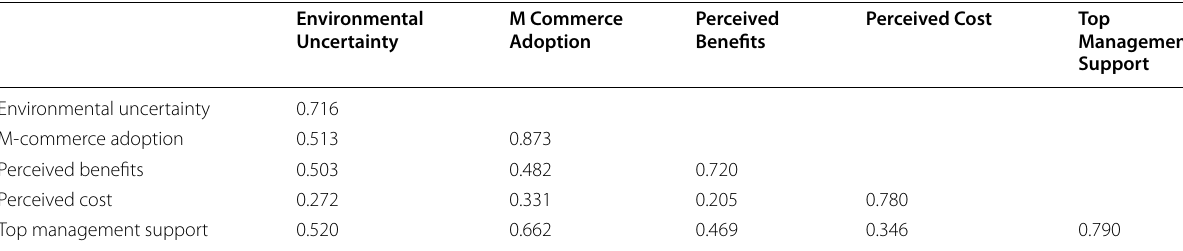
Table 4 Correlation matrix